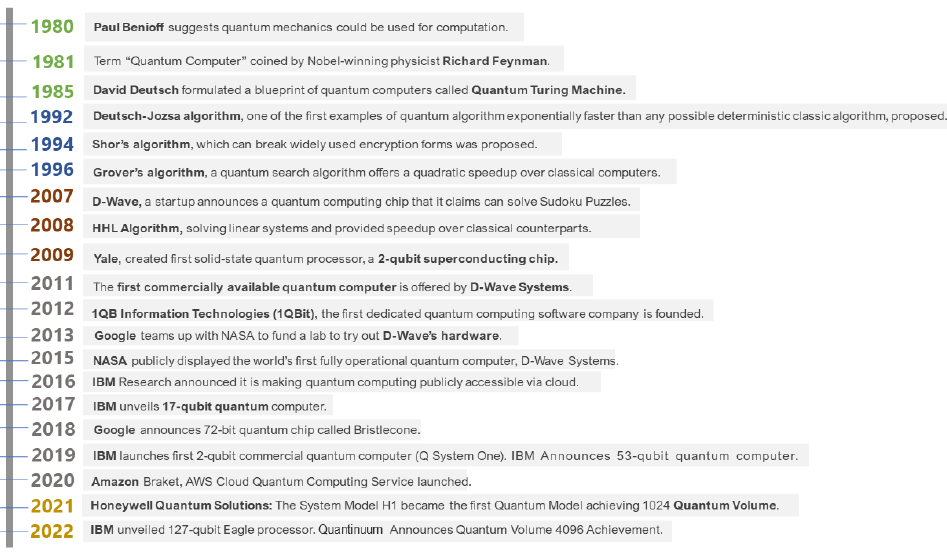
Figure 3. Timeline of developments in quantum computing